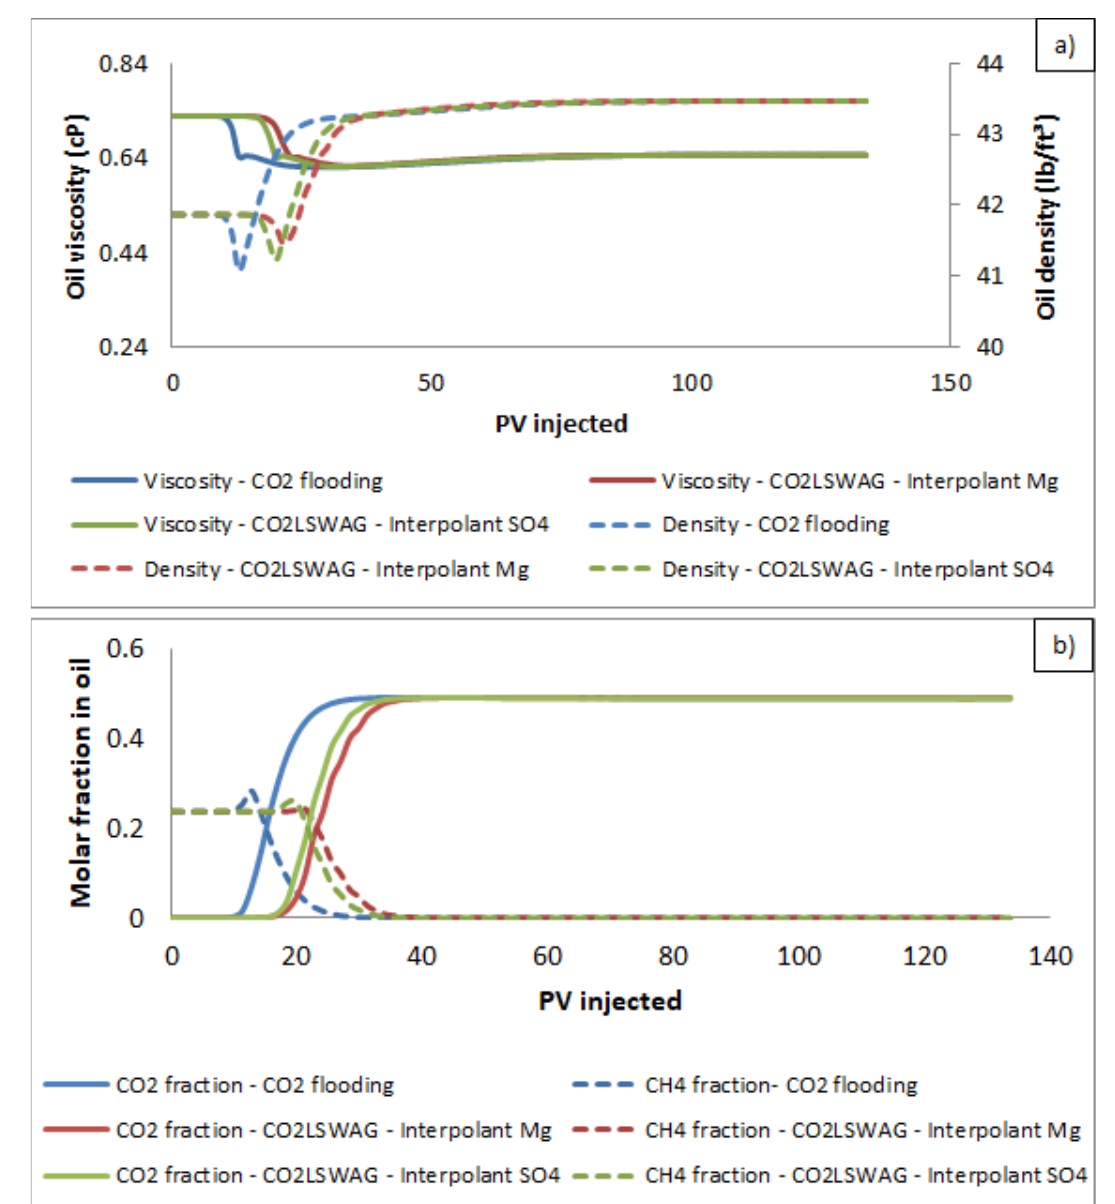
Figure 14. Results of ( a ) viscosity and density and ( b ) CO 2 molar fraction and CH 4 molar fraction of oil effluent for continuous CO 2 injection and CO 2 -LSWAG considering Mg and SO 4 as ion inter- polants.